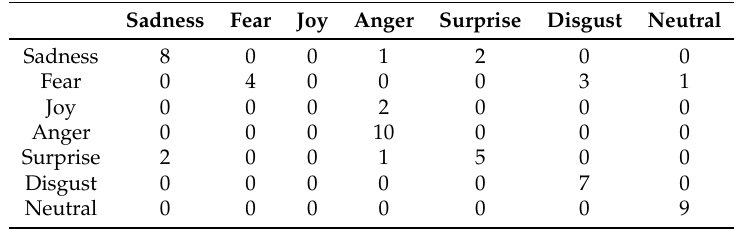
Table A22. A5 actor confusion matrix from the Emo-DB in the third phase.